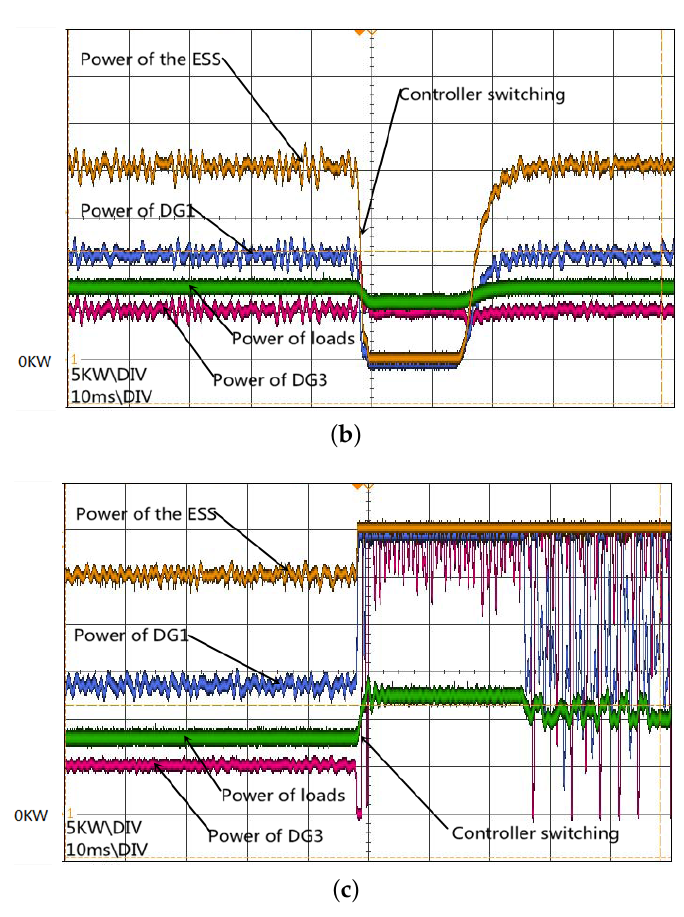
Figure 9. ( a , b ) Two non-passive converters: stable but seriously oscillate; and ( c ) three non-passive converters: